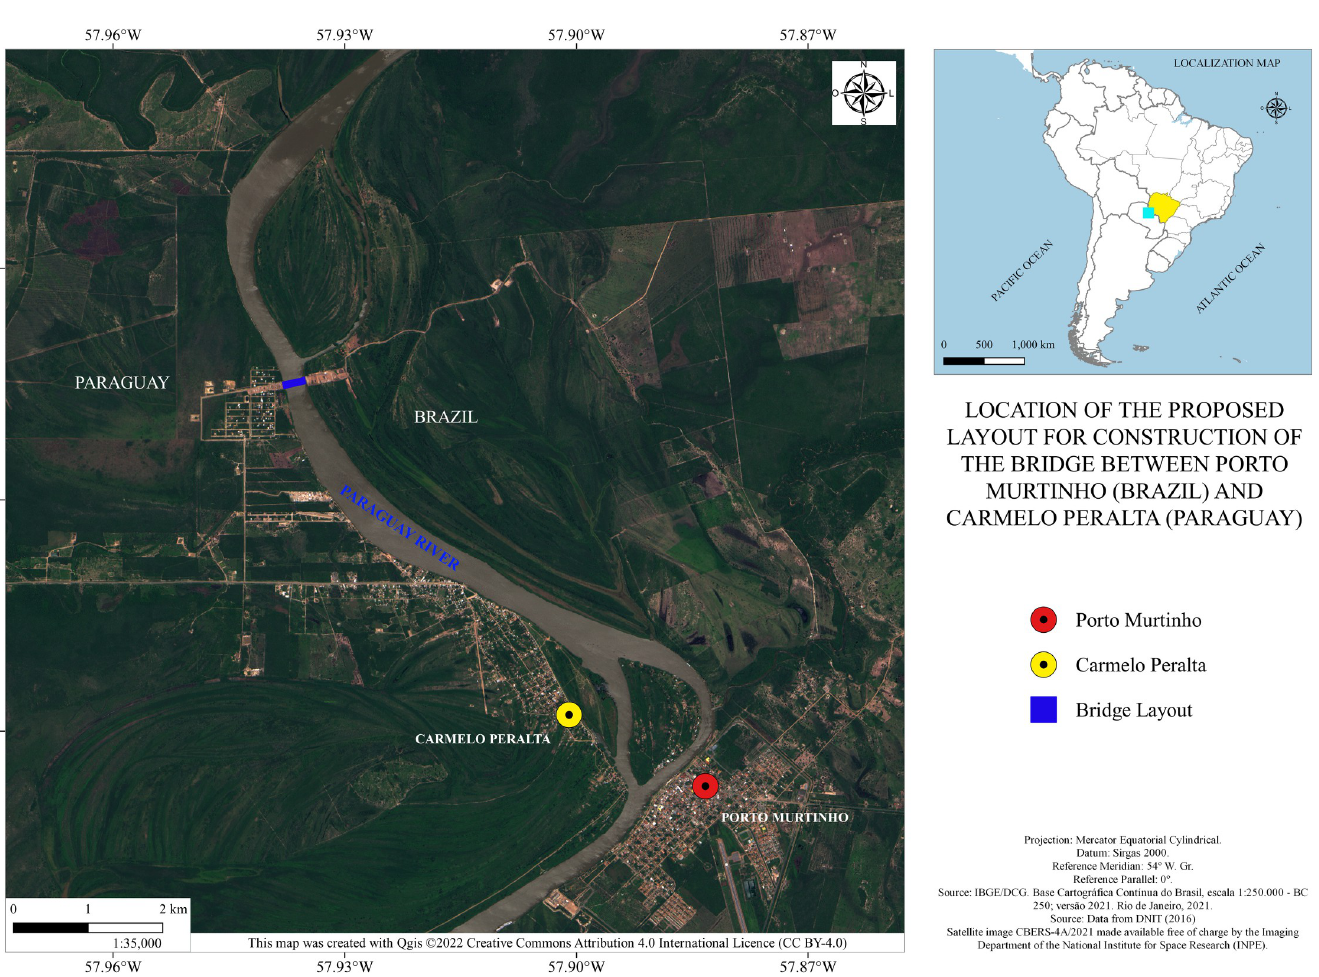
Fig 2. Location of the proposed layout for the construction of the bridge linking Porto Murtinho (Brazil) and Carmelo Peralta (Paraguay). Caption credit: Elaborated based on information from the [9, 13].